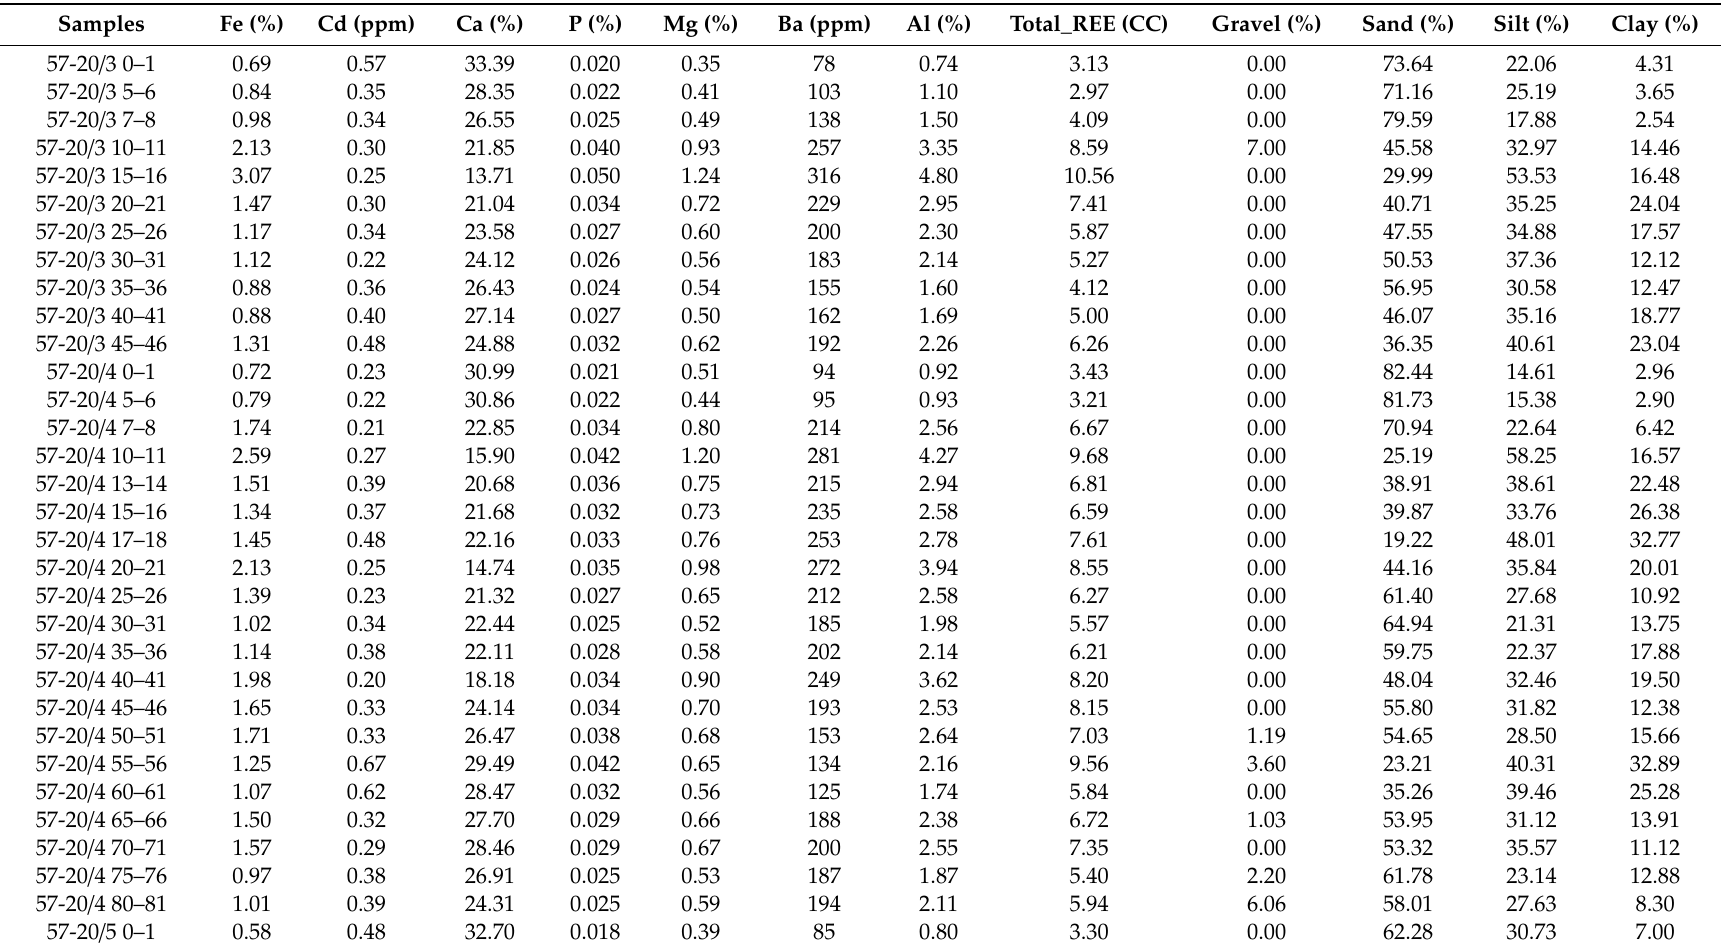
Table A1. Results of all the samples from the six gravity cores studied for geochemical composition and grain size